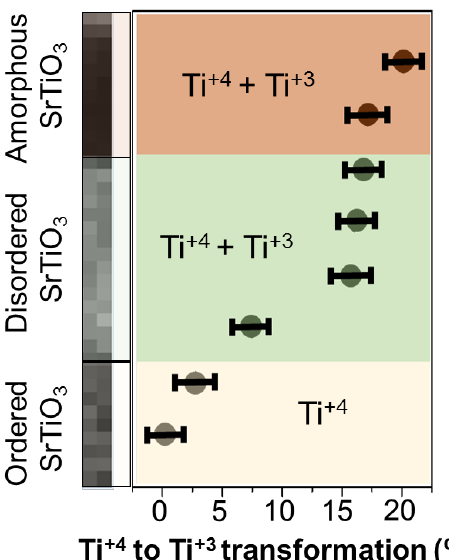
Figure 6. Depicts a variation of Ti oxidation states i.e., from ordered structure to amorphous region. In an ordered SrTiO 3 structure, Ti +4 ions have six-fold symmetry coordinated by O 2 − ions, where the Ti cation is at the center of the octahedron. This creates equivalent Ti-O bonds, leading to further Sr +2 ions surrounded by four TiO 6 octahedra [39]. SrTiO 3 is a good insulator with a bandgap of 3.2 eV (at T = 0 K) [21] and a possible candidate for high dielectric material, replacing SiO 2 [46]. Due to the pulsed laser irradiation, oxygen migration quickens in the SrTiO 3 structure. This leads to the formation of vacancies exceeding the equilibrium state. Therefore, in localized regions, the Ti +4 oxidation state transforms into a Ti +3 oxidation state. In our case, we observe a higher degree of disorder that can be correlated to the presence of a large number of non-equilibrium vacancies. Hence, we ob- serve a greater transformation of the Ti +4 oxidation state to Ti +3 oxidation state in the amor- phous region, resulting in the formation of an oxygen deficit SrTiO 3- δ structure . We con- clude that the presence of structural defects such as vacancies leads to the variation in electrical properties [47]. This transformation behavior in the SrTiO 3 crystal structure leads to localized polarization. This polarization effect could lead to future applications as a promising electronic material. 4. Conclusions In this research, the thermal transport simulations predict the melting of the SrTiO 3 surface by laser irradiation with the laser energy density of 300 mJ·cm −2 and above. This phenomenon results in the transformation of the crystalline SrTiO 3 into disordered and amorphous phases. Atomic-resolution electron microscopy was utilized to understand atomic rearrangements and structural transformations in SrTiO 3 single crystal irradiated from the [001] crystallographic direction. Due to nanosecond pulsed laser irradiation-in- duced melting and ultrafast quenching, the ordered single-crystalline SrTiO 3 transforms into an amorphous phase with an interposing disordered crystalline region between amorphous and ordered phase. The amorphous region was measured as ~35 nm, and the disordered region was ~65 nm in thickness. With EELS analysis, we confirmed the trans- formation of Ti +4 to Ti +3 due to oxygen vacancy formation. In the disordered region, the maximum transformation of Ti +4 was observed as 16.2 ± 0.2%, whereas in the amorphous region, the maximum transformation was observed as 20.2 ± 0.2%. We finally deduce that,